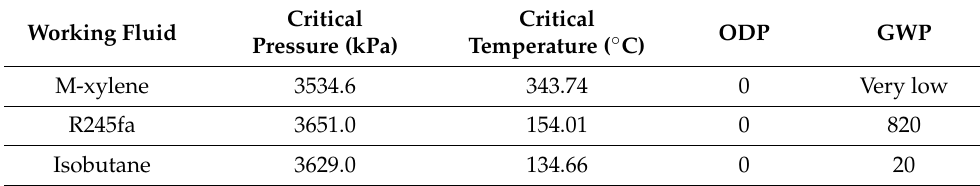
Table 2. Properties of the working fluids [15,33,48].